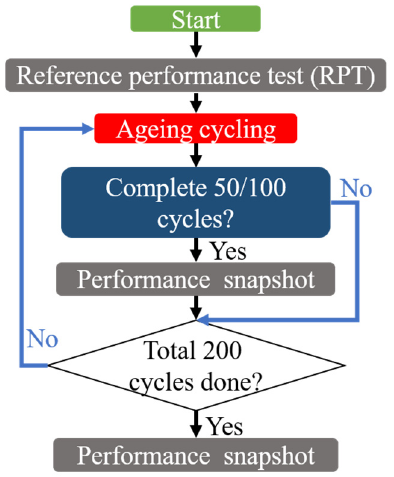
Figure 1. Flowchart of experimental procedures.